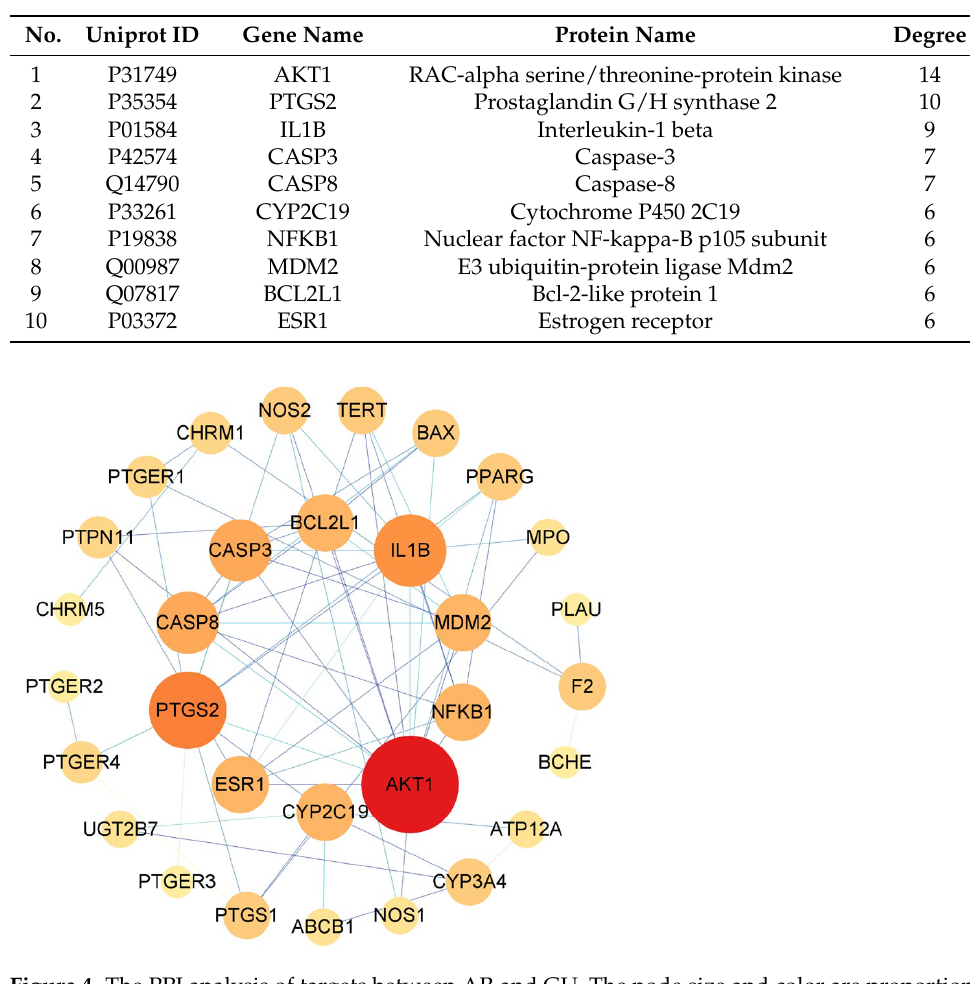
Table 3. The potential hub proteins ranked as top 10.